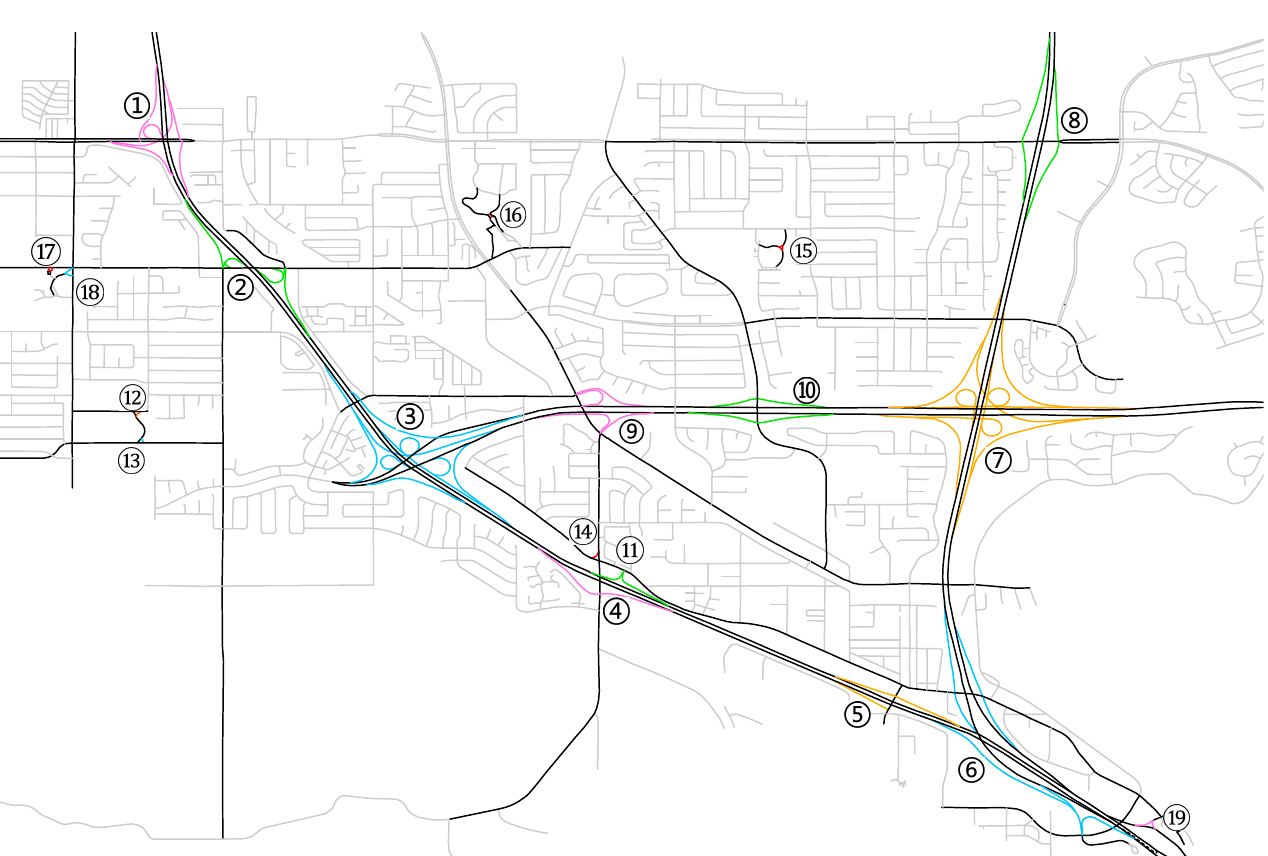
Figure 12. The result of applying the proposed method to the test dataset. For an identified complex junction, its secondary roads are in the same bright color while the participant primary roads are in black as one primary road can participate in more than one complex junctions. The rest roads that are not part of the complex junctions are in light